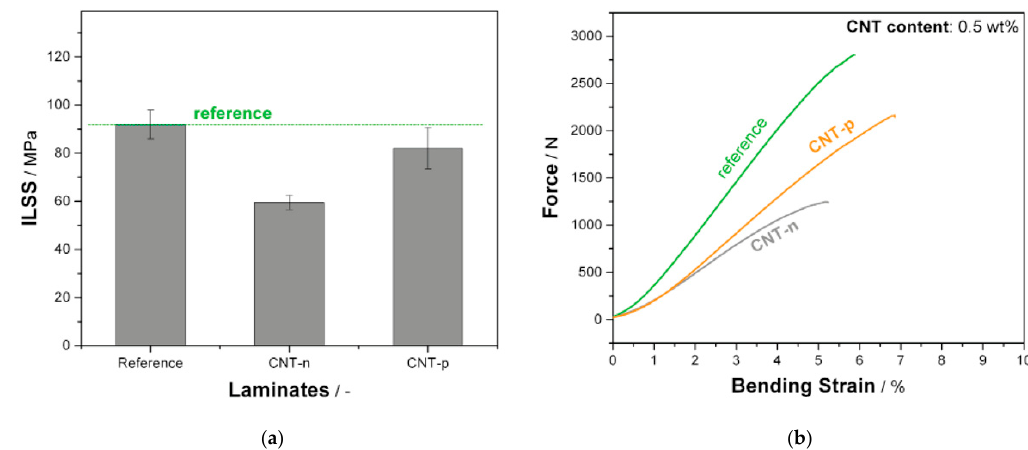
Figure 7. ( a ) Interlaminar shear strength (ILSS) of laminates. ( b ) F– ε (force–strain) diagrams. MWCNT contents are 0.5 wt.%.